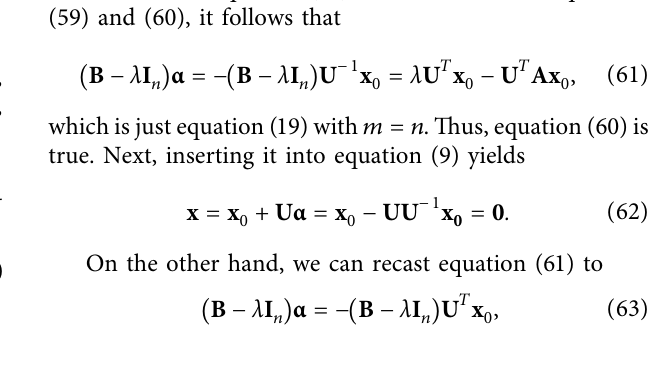
Figure 5: For Example 1, (a) showing characteristic curves obtained in n -dimensional space, (b) the peaks of μ μ and μ 3 4